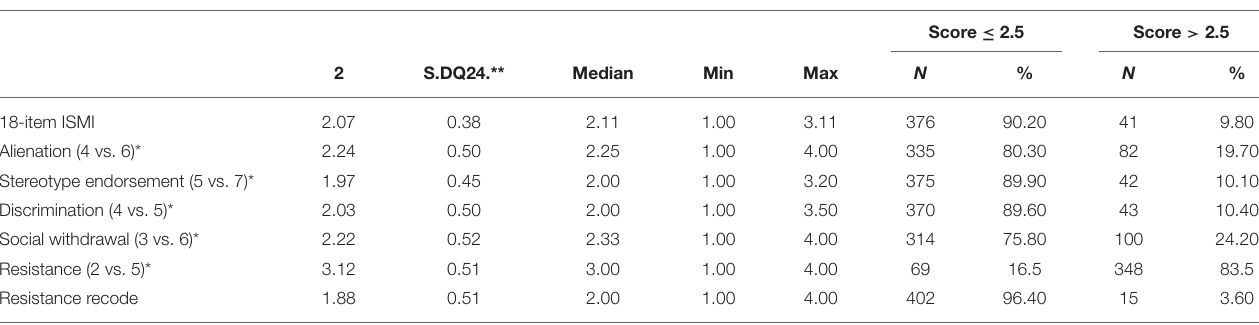
TABLE 3 | Distribution of scores on the 18-item ISMI and